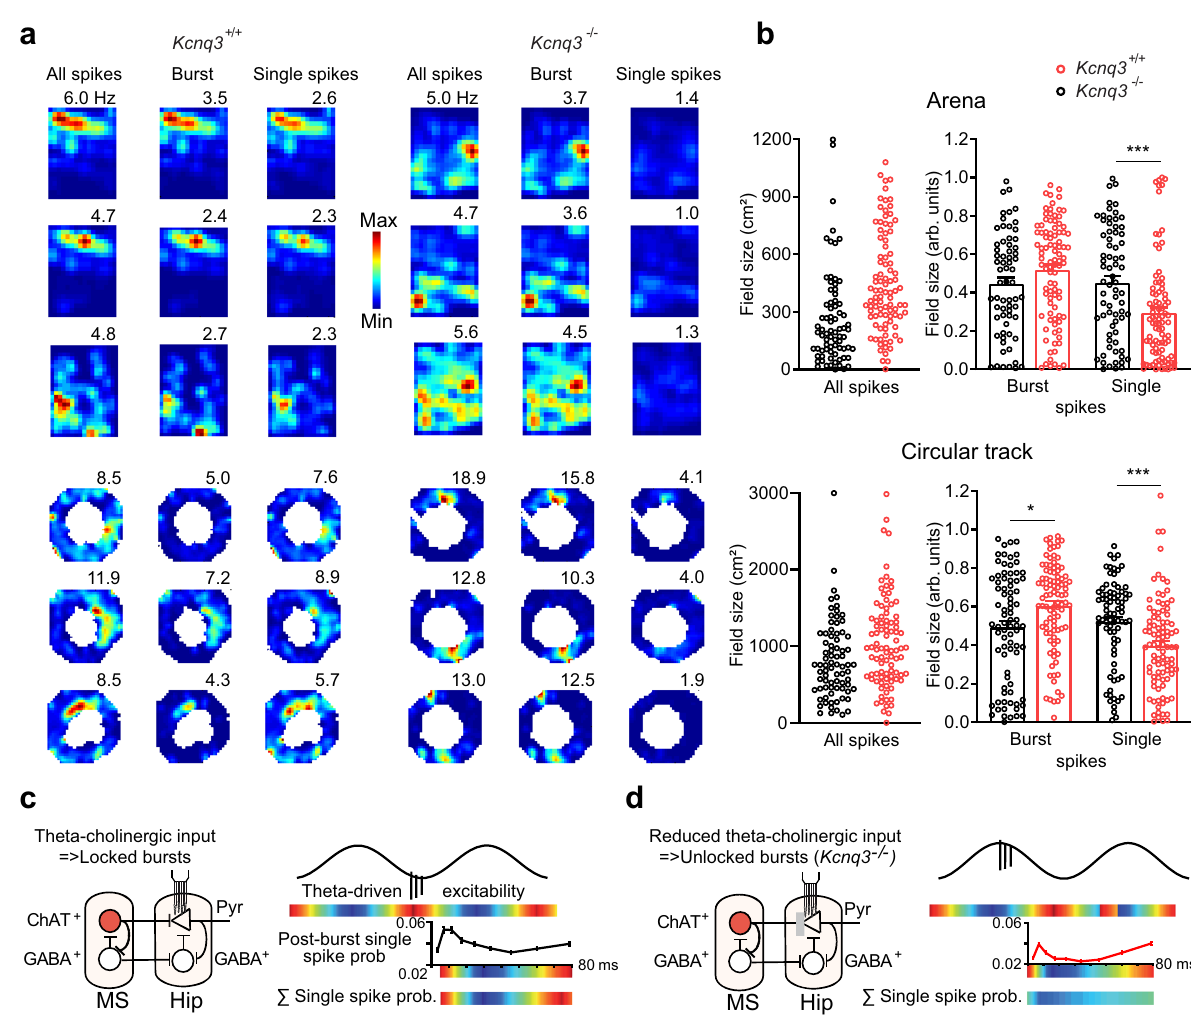
Fig. 3 Spatial representations by bursts and single spikes in Kcnq3 − / − and wild-type mice. a Firing maps of CA1 pyramidal cells recorded during navigation in a rectangular arena (top) or on a circular track (bottom). For each place cell, three fi ring maps were constructed: using all spikes (left), spikes fi red in bursts (middle) and only single spikes (right). Peak rates (Hz) indicated above of each map, color scales match across burst and single-spike fi ring maps in each cell. b Size of place fi elds in the arena ( n = 76 cells from 5 Kcnq3 + / + mice, black; n = 95 cells from 4 Kcnq3 -/- mice, red, ***, p = 0.0004, Mann – Whitney-U-Test) and on the track ( Kcnq3 + / + : n = 78 cells; Kcnq3 − / − : n = 94 cells *, p = 0.013, ****, p <0.0001). The color code is used for the entire fi gure. Schemes illustrating the impaired spatial fi ring of single spikes during intact ( c , Kcnq3 + / + ) and impaired ( d , Kcnq3 − / − ) entrainment of burst discharge. Inset curves show probability of a single spike emission as a function of silence duration after a burst ( n = 117 cells from 6 Kcnq3 + / + mice; n = 167 cells from 4 Kcnq3 − / − mice). Red circles, ChAT + cells; GABA + , inhibitory cells; Pyr, pyramidal cells. The sine wave denotes theta oscillation cycle, arb. units, arbitrary units. Data are presented as mean ± SEM, see also Supplementary Information, Statistical Analysis (Fig. 3b –